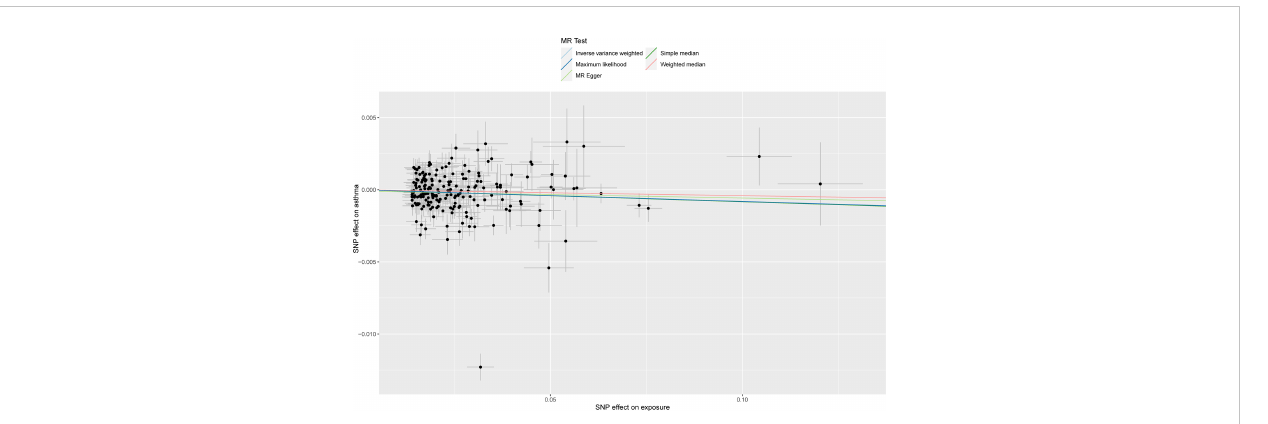
FIGURE 3 The scatter plot showed the genetic correlations between circulating IGF-1 and asthma using different MR methods. The slopes of line represent the causal effect of each method,